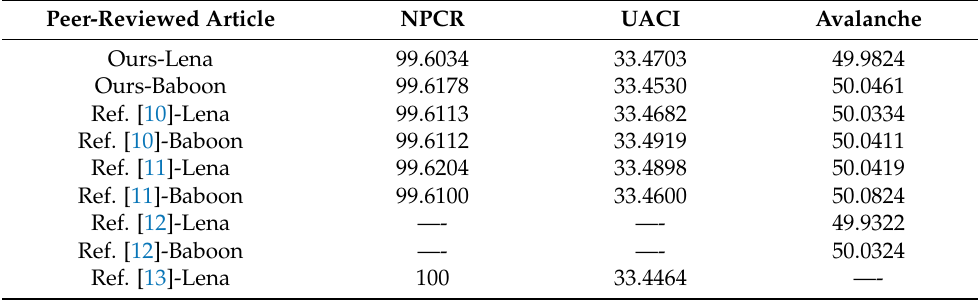
Table 14. Performance comparison between proposed scheme and others recently